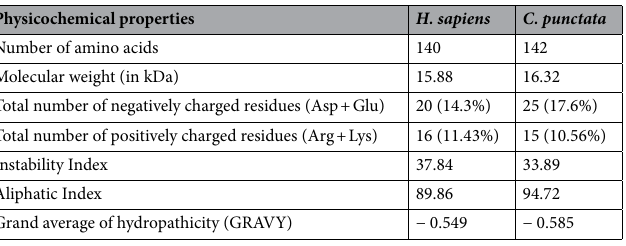
Table 1. Physicochemical properties of asprosin protein using ExPASy ProtParam tool.